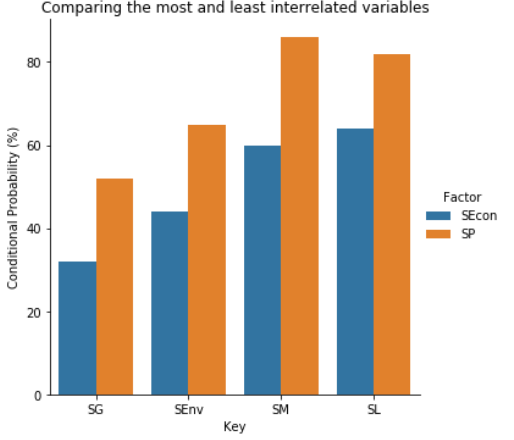
Figure 7. Comparison of the most and least interrelated variables.